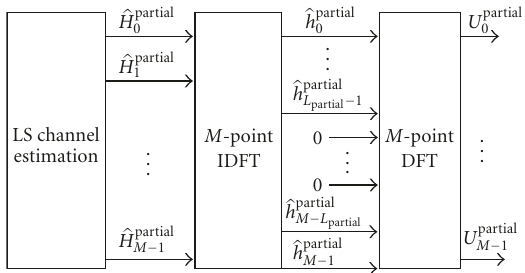
Figure 2: Block diagram of the partial frequency response DFT- based channel